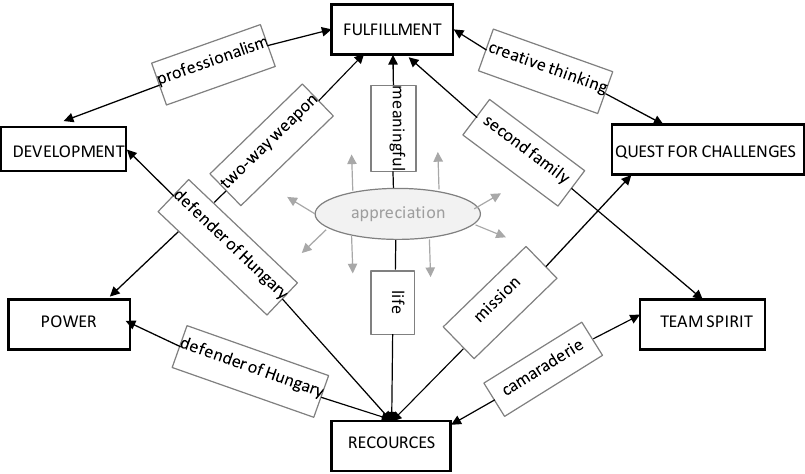
Figure 3. Selective codes and the terms belonging to them.